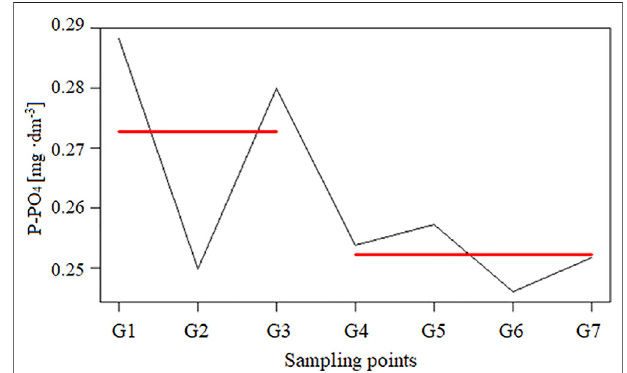
FIGURE 6 | Average content of orthophosphate phosphorous in the waters of the G ł uszynka river during hydrological years 2016 – 2018, with the in fl ection point indicated. Temporal variability of the content of nitrogen and phosphorus and their forms.